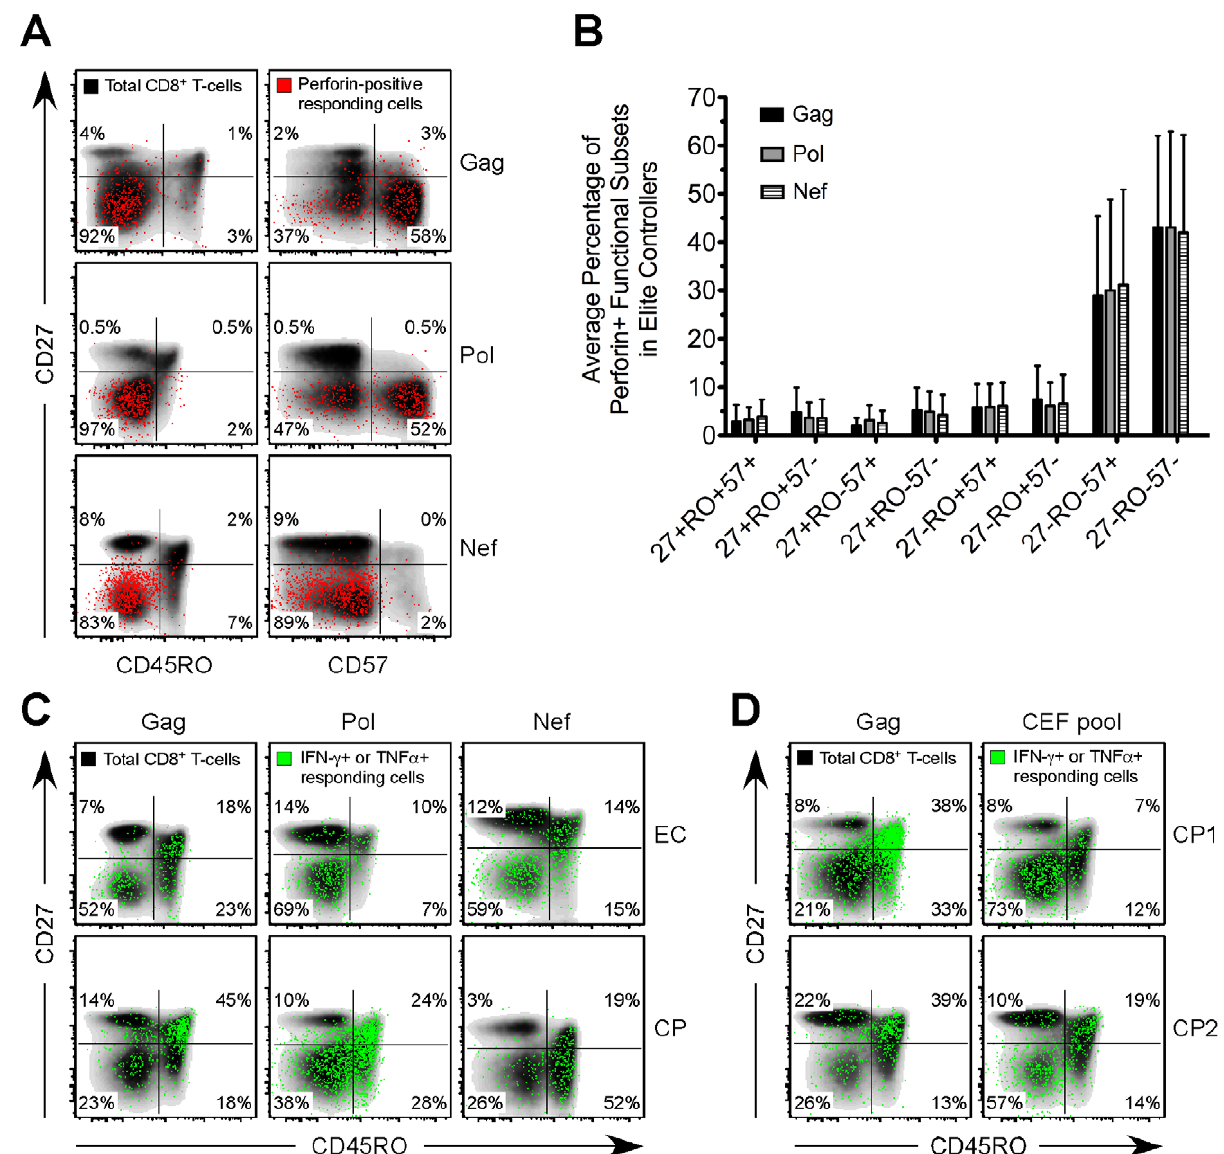
Figure 4. Distinct expansion of HIV-specific effector CD8 + T-cells in EC. (A) Gag-, Pol-, and Nef-specific perforin + functional subsets (red events) were overlaid onto a density plot (black shading) of the memory phenotype, as determined by CD27, CD45RO, and CD57, of the total CD8 + T- cell population in three representative EC subjects. (B) The memory phenotype of Gag-, Pol-, and Nef-specific perforin + functional subsets, as determined by CD27, CD45RO, and CD57, was determined for all EC. Bars represent the mean and error bars indicate the standard deviation. (C) Gag-, Pol-, and Nef-specific CD8 + T-cells, as defined by the production of IFN- c or TNF a (green events), were overlaid onto a density plot (black shading) of the memory phenotype, as determined by CD27 and CD45RO, of the total CD8 + T-cell population in three separate EC and CP subjects. (D) Gag- and CEF-specific CD8 + T-cells, as defined by the production of IFN- c or TNF a (green events), were overlaid onto a density plot (black shading) of the memory phenotype, as determined by CD27 and CD45RO, of the total CD8 + T-cell population in two separate CP subjects. (A, C, D) Percentages represent the fraction of overlaid cells that fall within each quadrant.